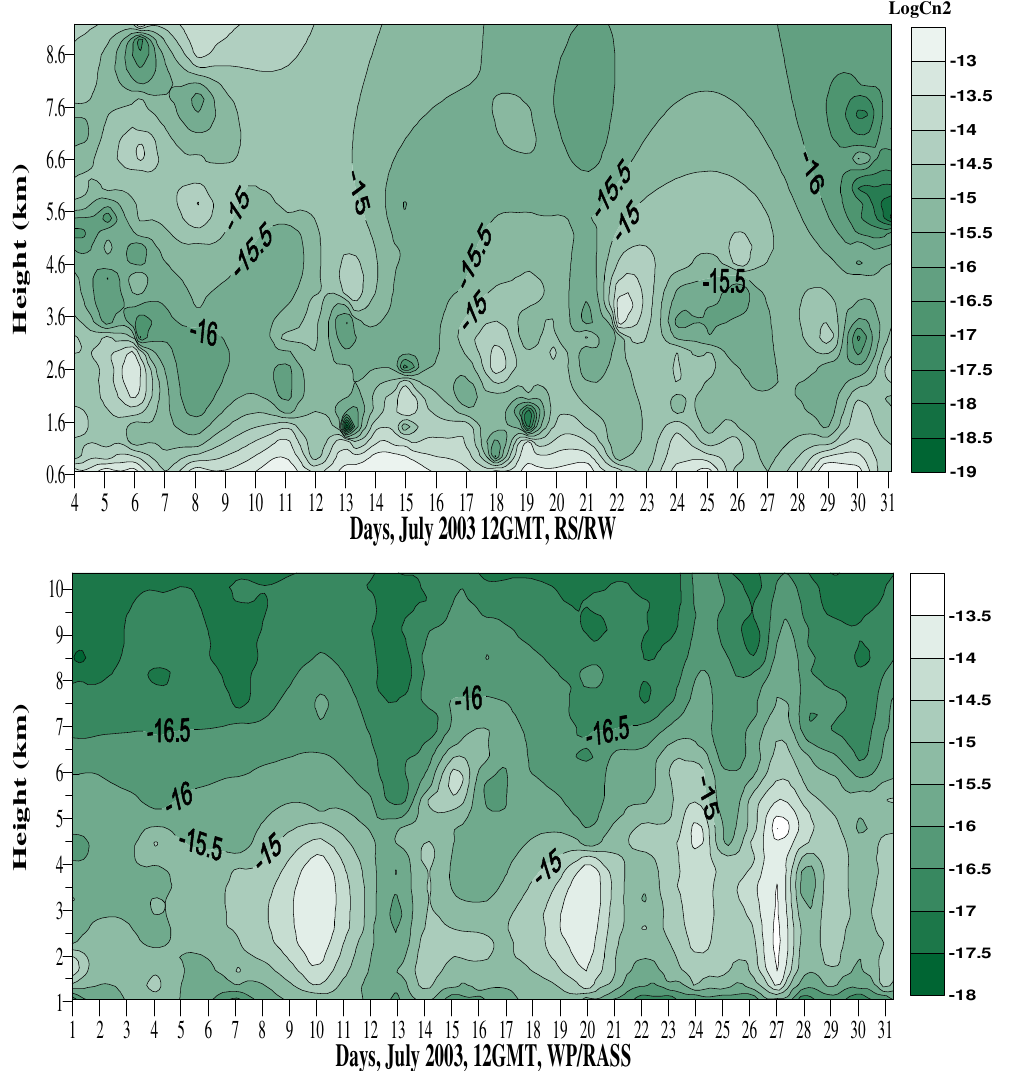
Fig. 1. Height profile of C 2 n as calculated from RS/RW (upper panel) and wind profiler Observations (lower panel). The radiosonde Figure 1 observations start at few meters (0.6km) above the ground and wind profiler observations at 1.05km onwards, the contours above 1 km are to be taken for